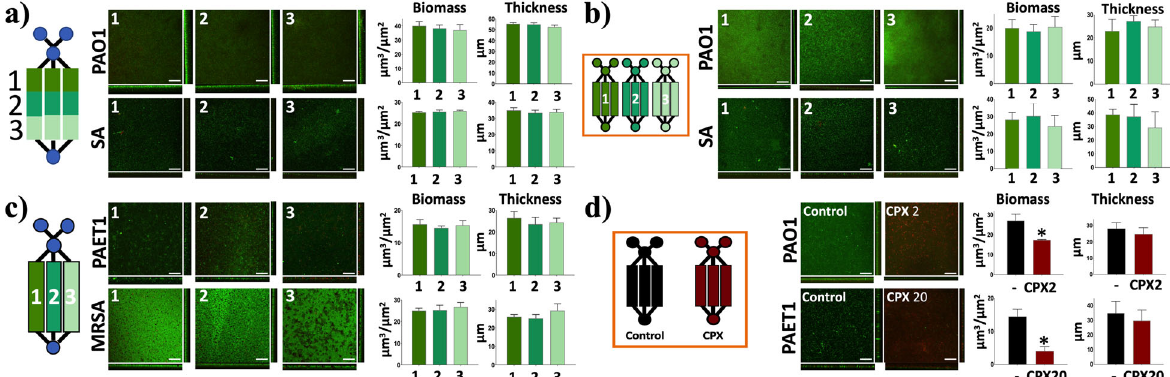
Fig. 3 Bio fi lmChip robustness evaluation. Uniformity in the established bio fi lm biomass and thickness across different chamber locations ( a ), between sets of chambers ( b ), and among chambers in the same set ( c ). Decreases in biomass and thickness after 24 h of treatment of P. aeruginosa PAO1 and PAET1 with cipro fl oxacin ( d ). In all cases, 72-hour-old bio fi lms were stained and visualized by confocal microscopy (CLSM). Images represent the sum of stacked CLSM images and their corresponding orthogonal views, and bars show the quanti fi ed bio fi lm biomass ( μ m 3 / μ m 2 ) and average thickness ( μ m) with error bars of the three different replicates. Scale bar represents 50 μ m. The results presented in this fi gure are representative of the same experiment repeated at least three times, producing similar results every time. PAO1 ( P. aeruginosa PAO1 laboratory strain), PAET1 ( P. aeruginosa PAET1 clinical isolate strain), SA ( S. aureus laboratory strain), MRSA ( S. aureus MRSA clinical isolate strain), CPX2 (cipro fl oxacin 2 µg/ml), CPX20 (cipro fl oxacin 20 µg/ml). * p < 0.05 vs. control in a t